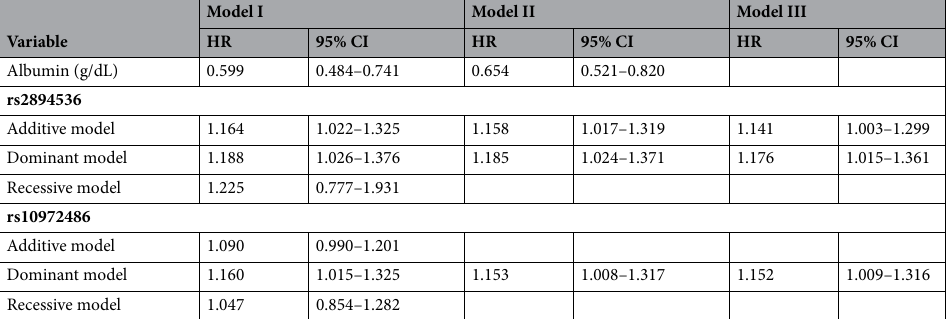
terol level (Table 4 and Supplementary Table S3). Subsequent survival analyses with multiple Cox-proportional hazards regression analysis and log-rank test were performed to compare hypertension-free survival between the groups. We found that participants with serum albumin ≤ 4.0 g/dL and polymorphisms of rs2894536 or rs10972486 had poor hypertension-free survival rate (Fig. 2).